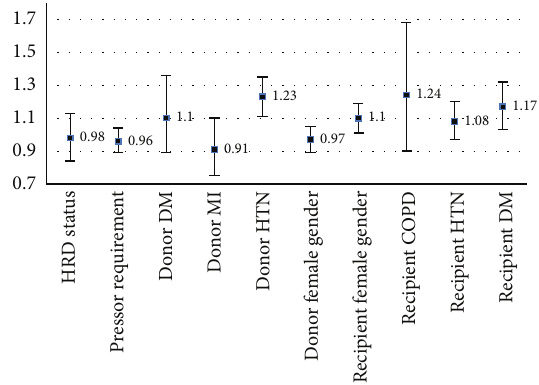
Figure 2: Donor hypertension, recipient female gender, and recip- ient diabetes mellitus (DM) increase risk of graft failure. When controlling for donor and recipient factors, IRD status (HRD) does not independently impact